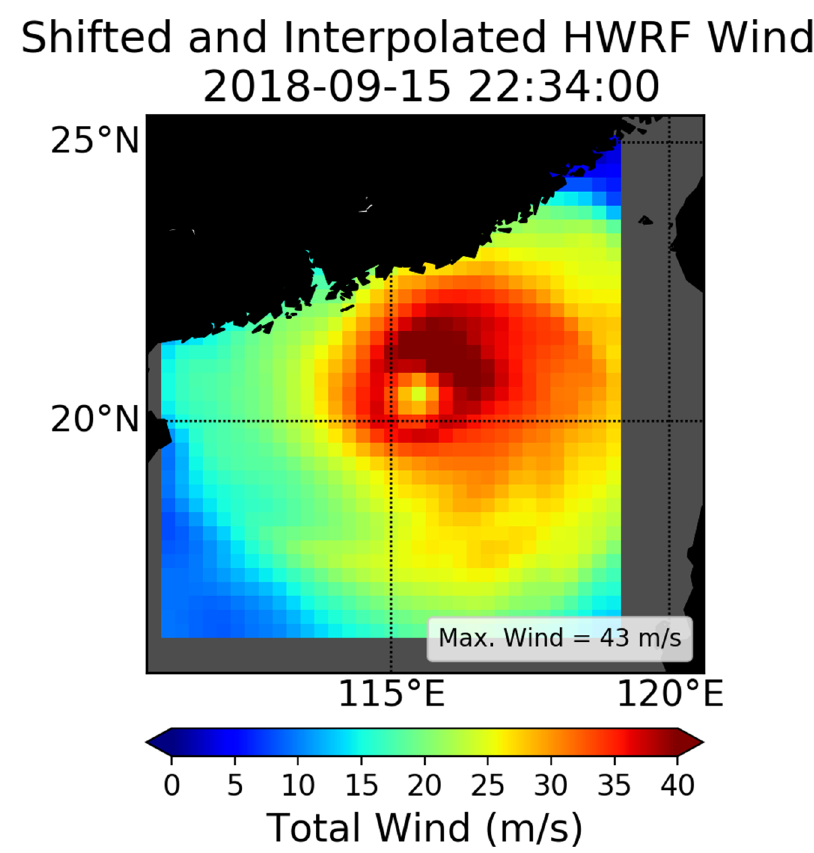
Figure 9. The resampled HWRF wind field to be compared with the SMAP pass over Typhoon Mangkhut on 15 September 2018 created by first shifting the surrounding HWRF winds before in- terpolating.